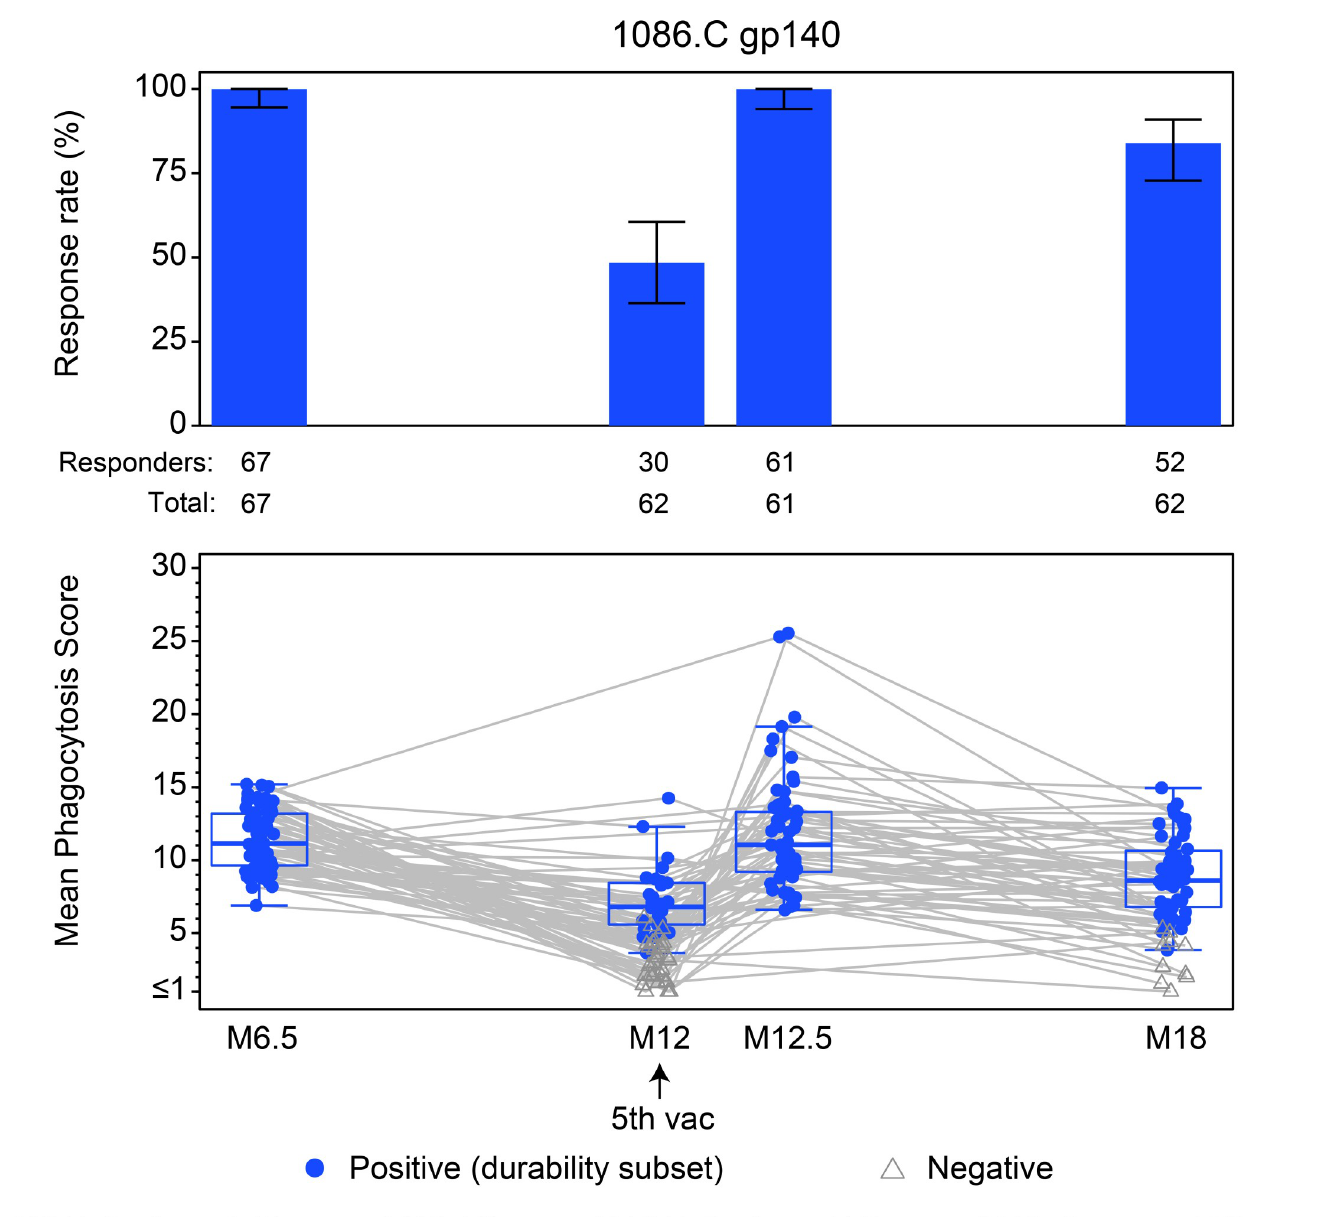
Fig 5. Summary of response rates and magnitudes of antibody-dependent cellular phagocytosis to 1086.C gp140 among per-protocol vaccine recipients of HVTN 100. Bar charts show response rates with 2-sided 95% CIs. Boxplots show magnitude as mean phagocytosis scores to 1086.C gp140 and are based on positive responders, shown as solid blue circles; negative responders are shown as grey triangles. Grey lines connect the response magnitude of each per-protocol vaccine recipient over time. M[number], month [number]; vac, vaccination.